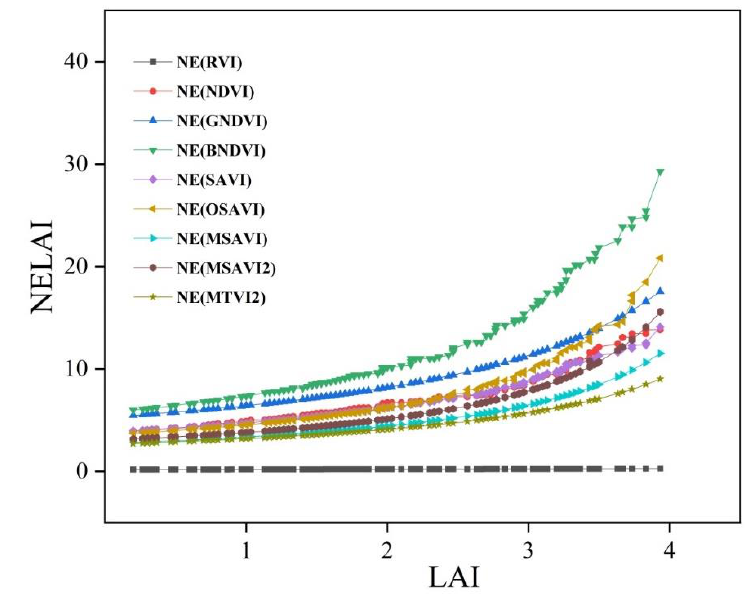
Figure 2. Sensitivity analysis for VIs evaluated for LAI estimation.